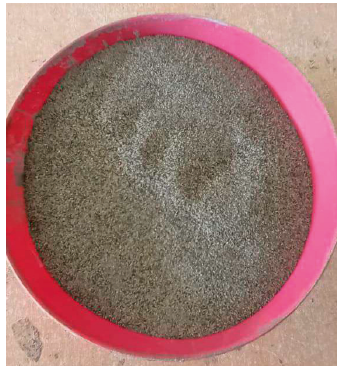
Figure 1: M-sand.